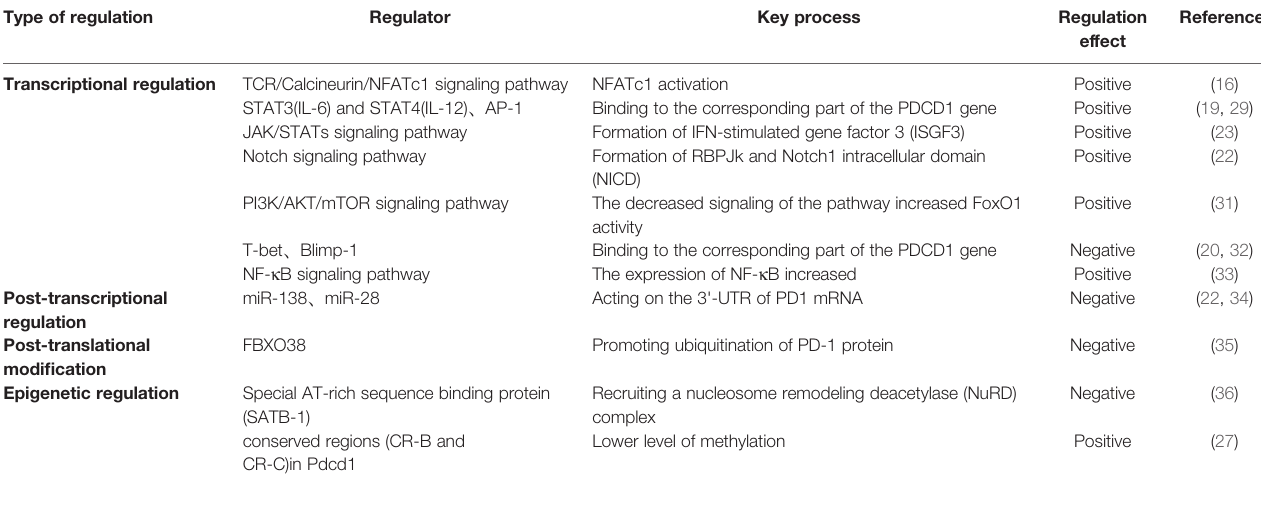
TABLE 1 | Regulation mechanism of